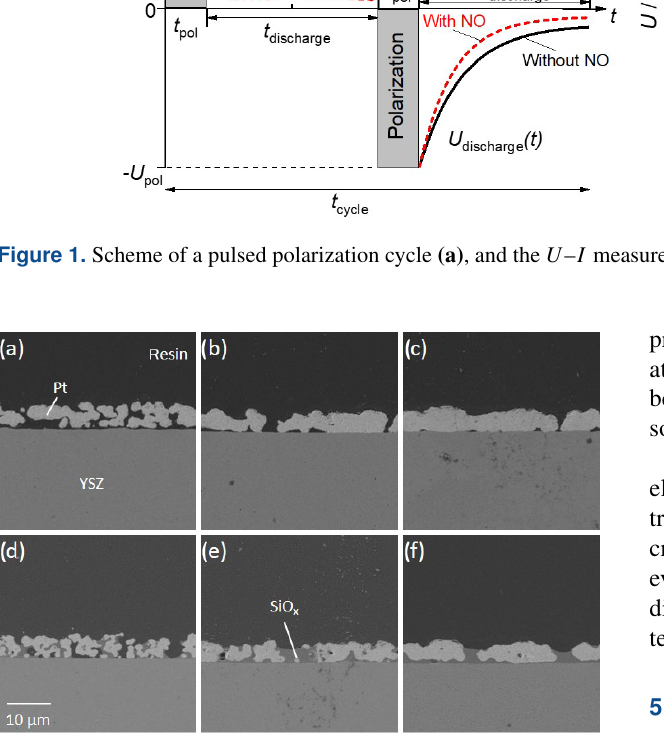
Figure 2. SEM cross section images of the electrodes without (a–c) and with glass frit (d–f) , fired at 950 ◦ C (a, d) , 1100 ◦ C (b, e) , and 1300 ◦ C (c, f)